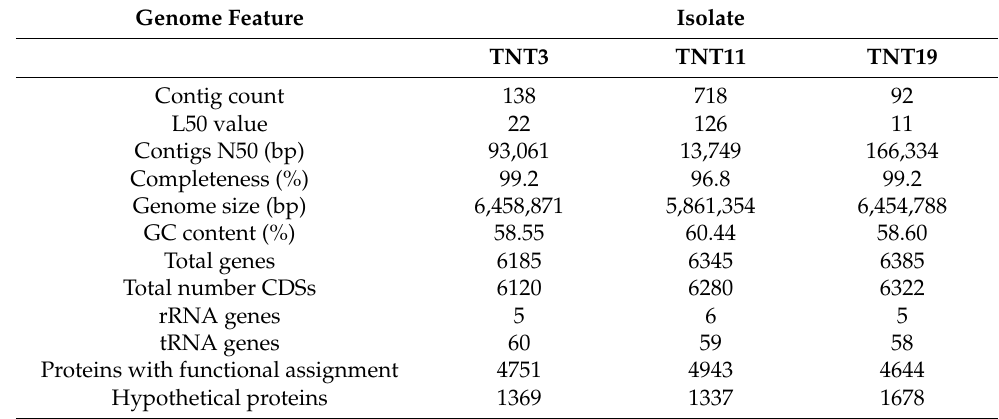
Table 1. General features of TNT isolates’ draft genome assemblies. Gene counts correspond to PATRIC/RASTtk annotation results. Completeness metrics are the result of BUSCO and CheckM